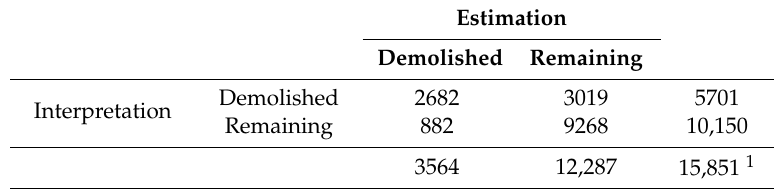
Table 8. Confusion matrix by the indicator and threshold of 0.3 for 25 March 2018